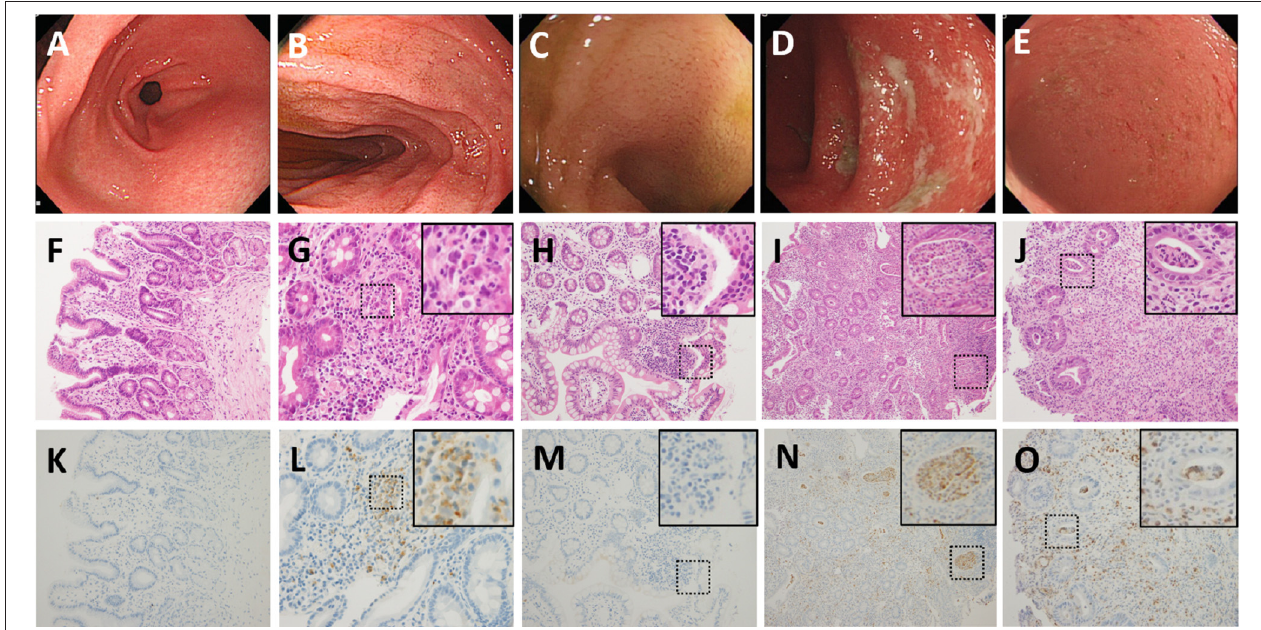
FIGURE 1 | Representative biopsy site-oriented images of esophagogastroduodenoscopy, histopathology, and in situ PR3 immunohistochemical staining during the third and fifth hospitalizations. Esophagogastroduodenoscopy revealed hyperemic mucosa with hyperemic spots in (A) gastric antrum and (B) dilated duodenum lumen compatible with superficial gastritis and distal obstruction; colonoscopy revealed hyperemic edematous mucosa in the (C) terminal ileum, diffuse ulcerations of mucosa with exudates and easy touch bleeding in the (D) ascending colon and (E) sigmoid colon. Histopathology through hematoxylin and eosin staining and PR3 immunohistochemical staining (magnification power 200 × ) of biopsies revealed chronic inflammatory infiltrates and distorted glandular architecture in the (F,K) gastric antrum, (G,L) duodenum, (H,M) terminal ileum, (I,N) ascending colon, and (J,O) sigmoid colon with locally magnified insets (400 × ) revealing PR3-positive neutrophils focally stained in the (L) duodenal mucosa and densely stained in the mucosa of ascending and sigmoid colons, especially in (N,O) crypt abscesses, but sparsely in the (M) terminal